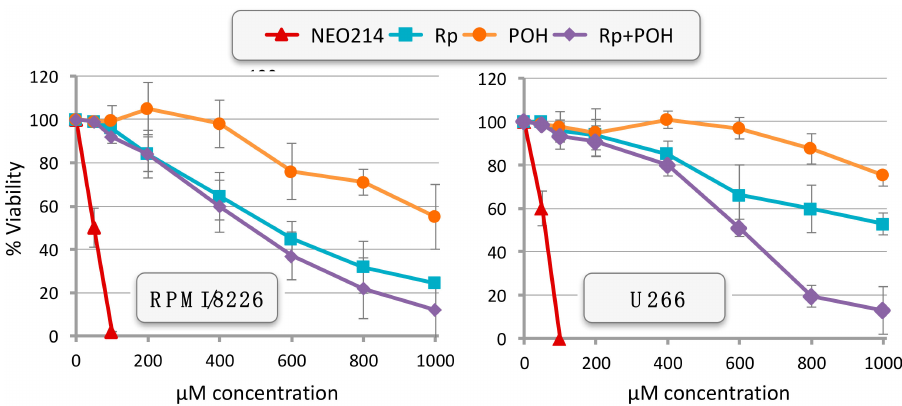
Figure 3. NEO214 is more cytotoxic than the sum of its parts. RPMI/8226 and U266 cells were treated with increasing concentrations of NEO214, Rolipram (Rp), perillyl alcohol (POH), or an equimolar mix of Rp plus POH. Cell survival was determined 48 h later by MTT assay. Survival of vehicle-only treated cells was set at 100%. Data points are mean ± SE from ≥ 3 independent